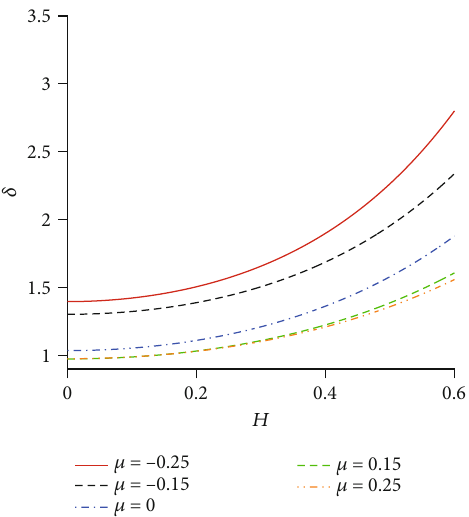
Figure 4: The in fl uence of the vorticity parameter μ on the phase Þ for di ff erent wave amplitude H velocity δ ð = c 2 / c 2 0